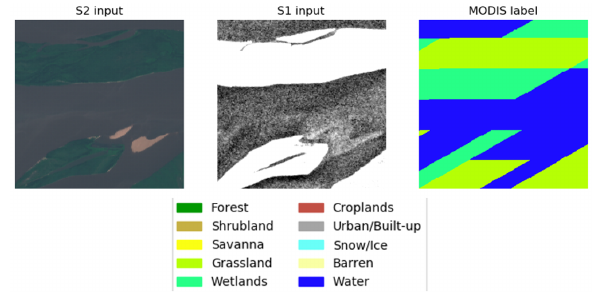
Figure 4: An example of SEN12MS